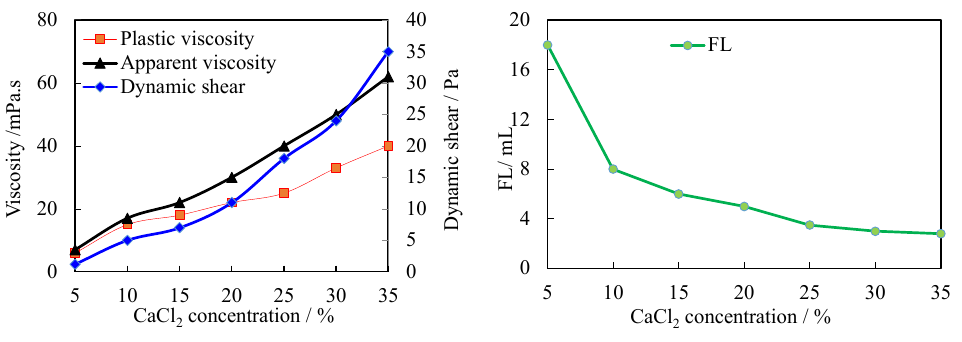
Figure 8. Evaluation of salt resistance of modified starch.